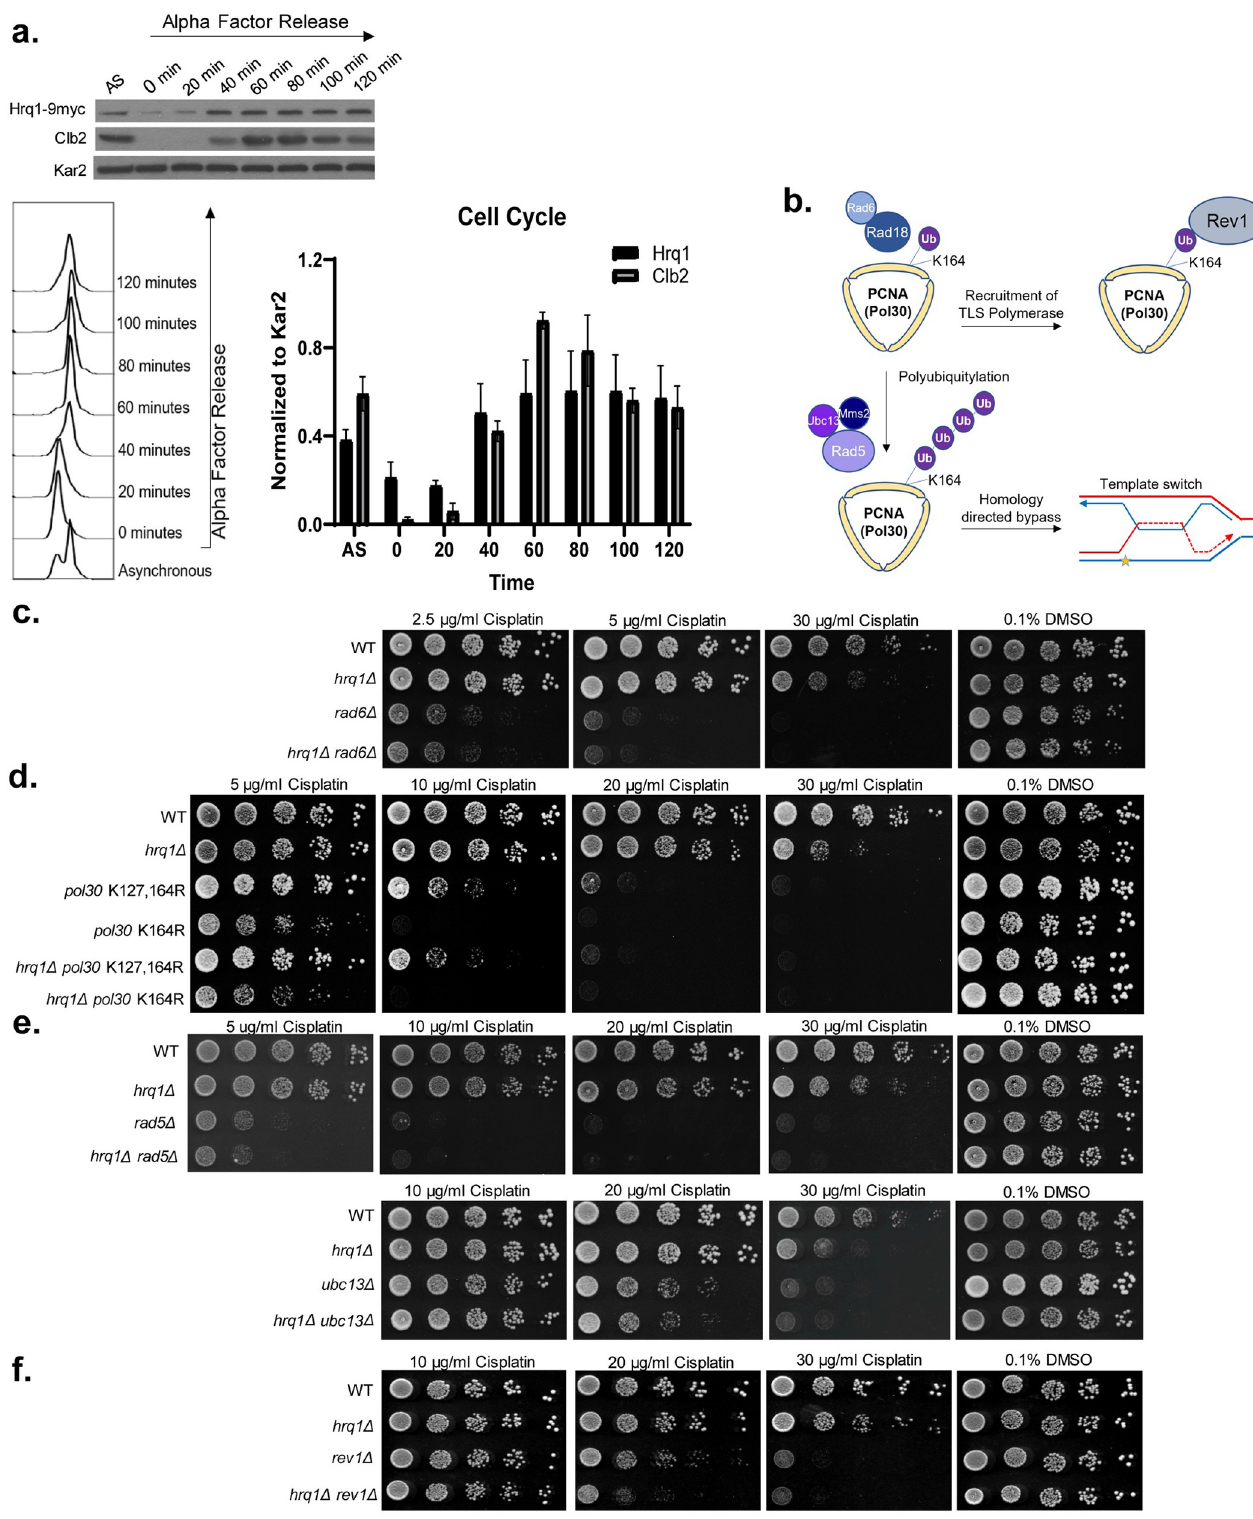
Fig 3. Hrq1 functions during error-free post-replicative repair. (A) Hrq1 expression increases during S/G2 and then plateaus. Hrq1-9xMYC expressing cells were either untreated (asynchronous, AS) or cell cycle arrested in G1 with α -factor. The α -factor arrested cells were subsequently released into fresh